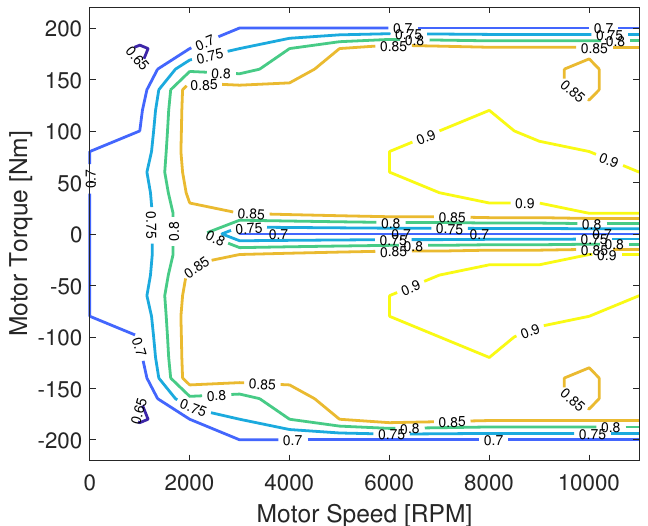
Figure 4. Motor efficiency